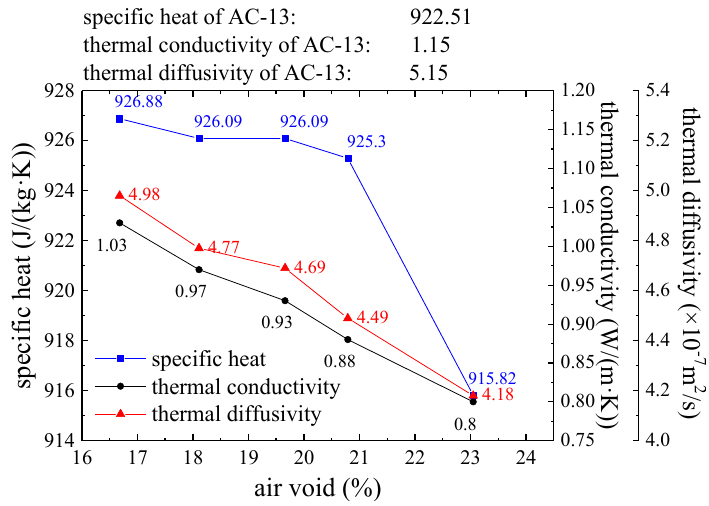
Figure 2. Thermophysical properties of PAC-13 mixtures with different proportions of air